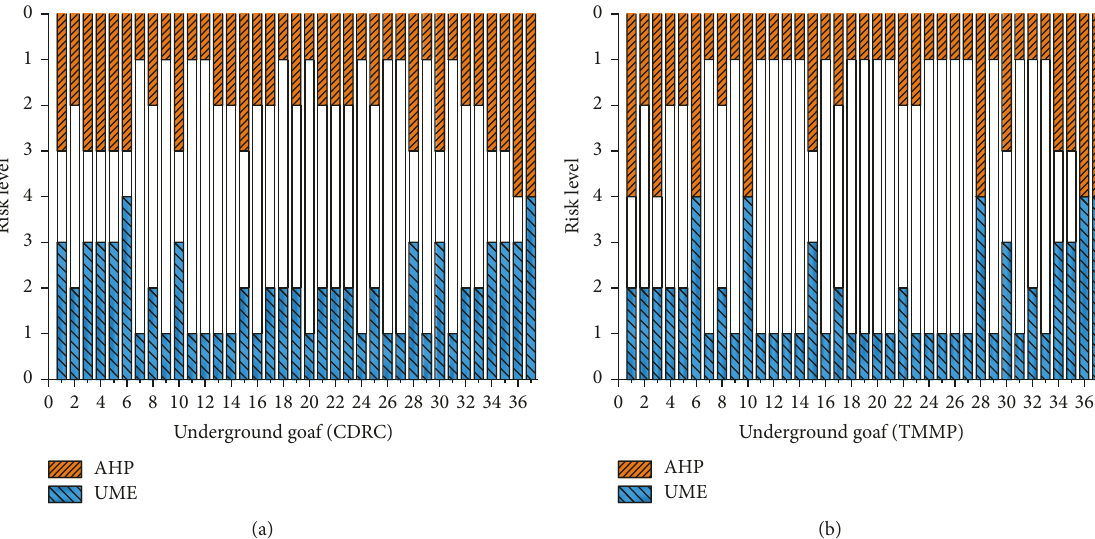
Figure 7: The comparison results for risk levels of 37 underground goafs. The graph (a) shows the risk levels of underground goafs using CDRC, and the graph (b) shows the risk levels using TMMP, where the blue part represents the risk levels of UME and the orange part represents the risk levels of AHP.